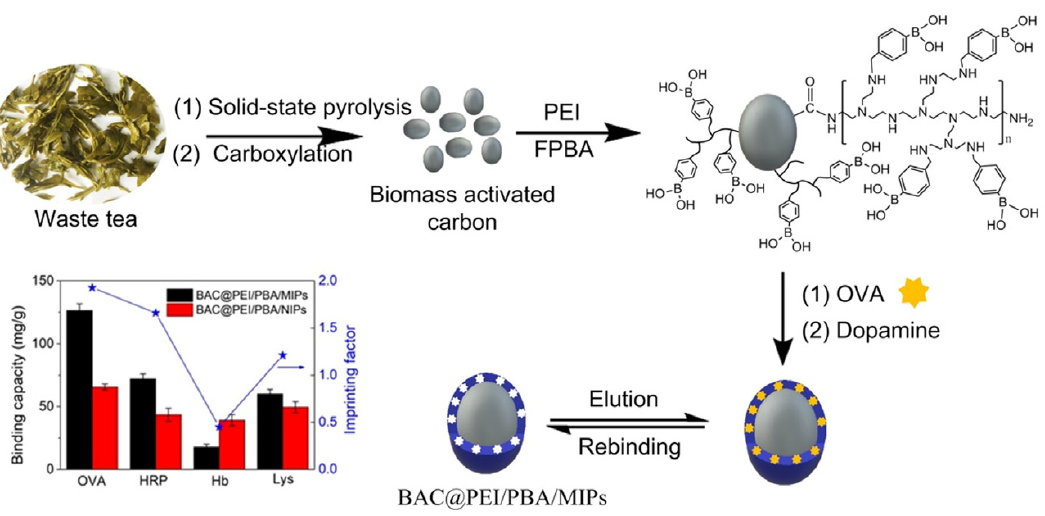
Figure 9. Synthesis procedure, binding capacity and imprinting factors of BAC-based molecularly imprinted polymers. Reproduced from the work in [94] with permission from Elsevier.